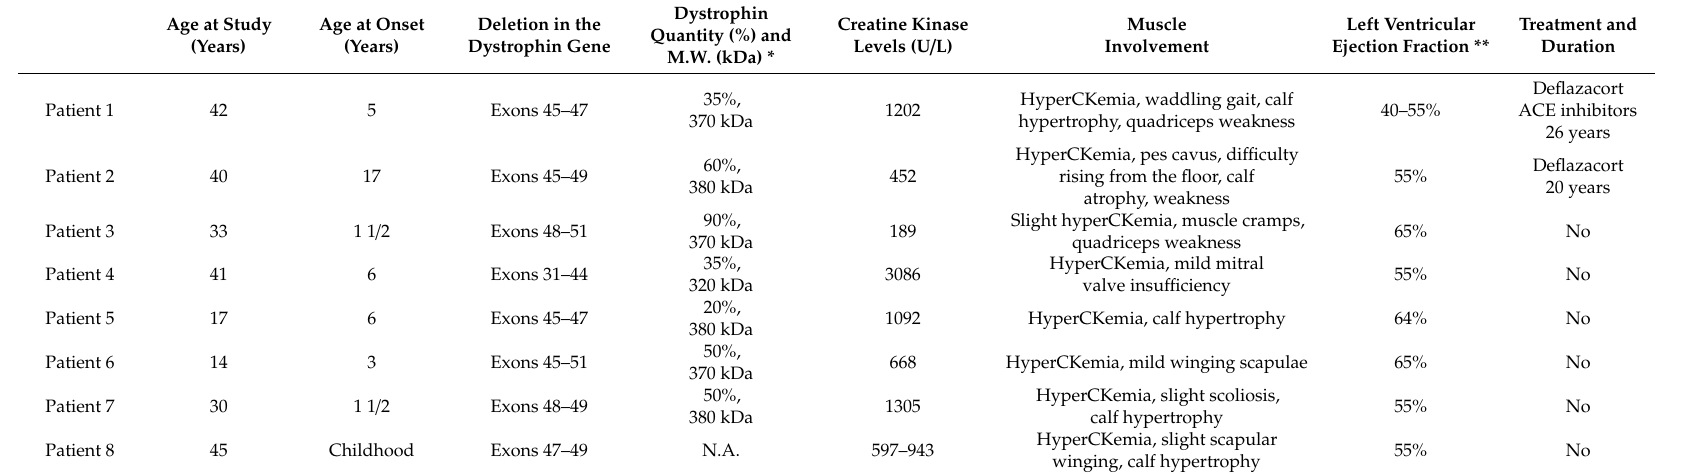
Table 1. Clinical features and dystrophin gene mutation in Becker muscular dystrophy (BMD)